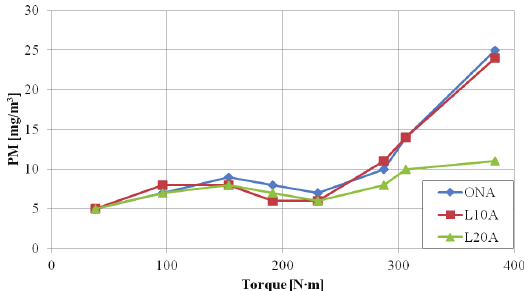
Fig. 6. PM for injection timing B and n = 1400 rpm